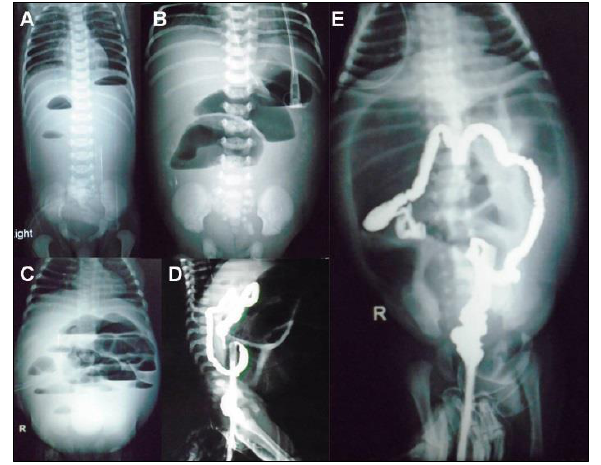
Figure 2: Triple-bubble sign (A) in a case of jejunal atresia; dilated bowel loops with a few air-fluid levels in a case of jejunal atresia (B); dilated bowel loops with multiple air-fluid levels a case of ileal atresia (C); gastrografin enema showing unused colon in a case of ileal atresia (D,E).